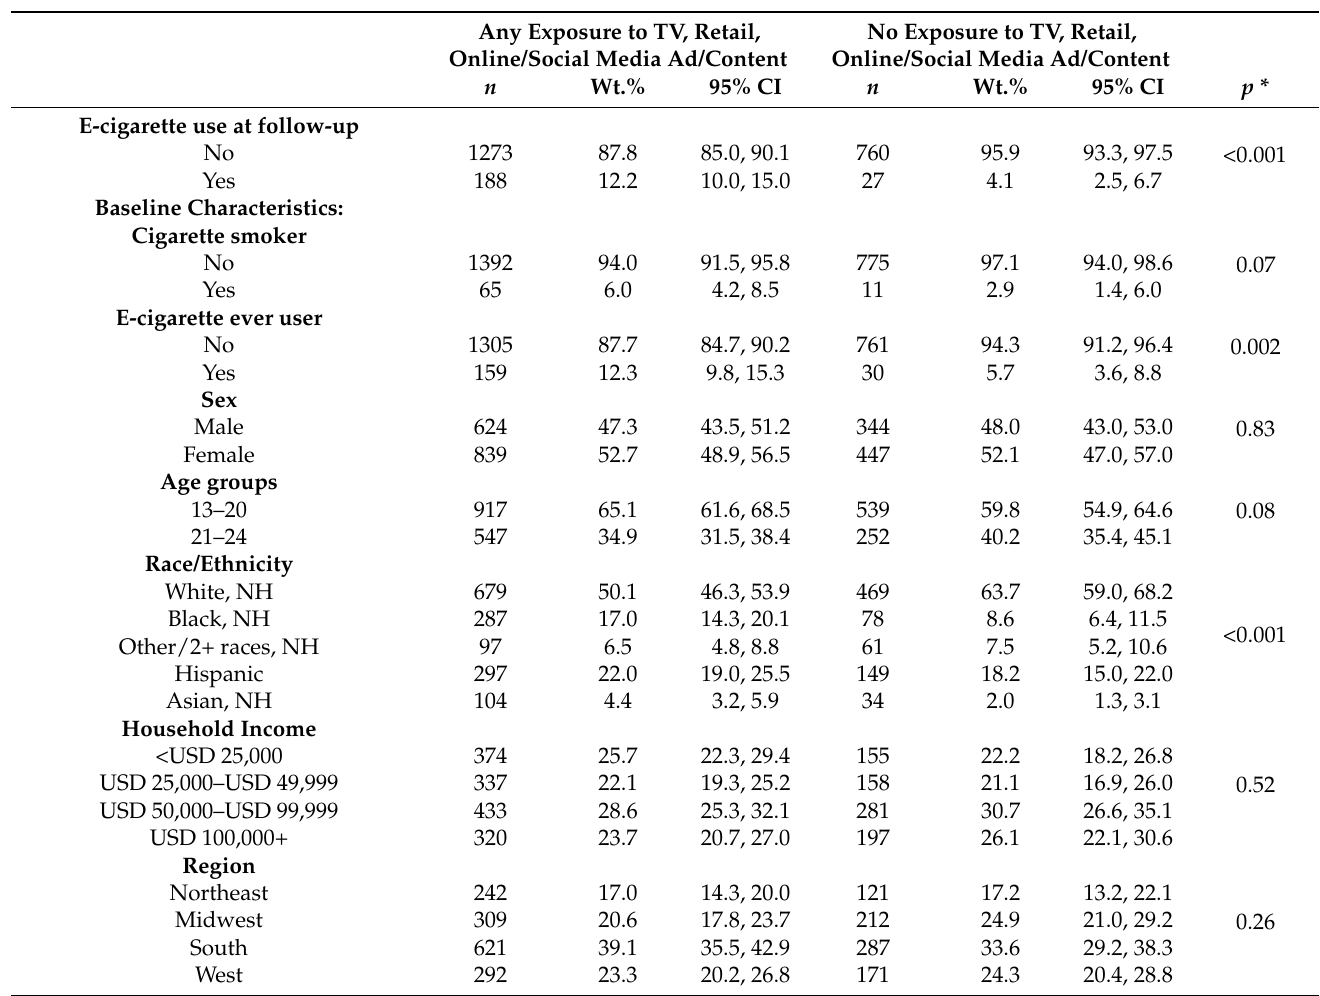
Table 2. Participant characteristics by e-cigarette advertising exposures.